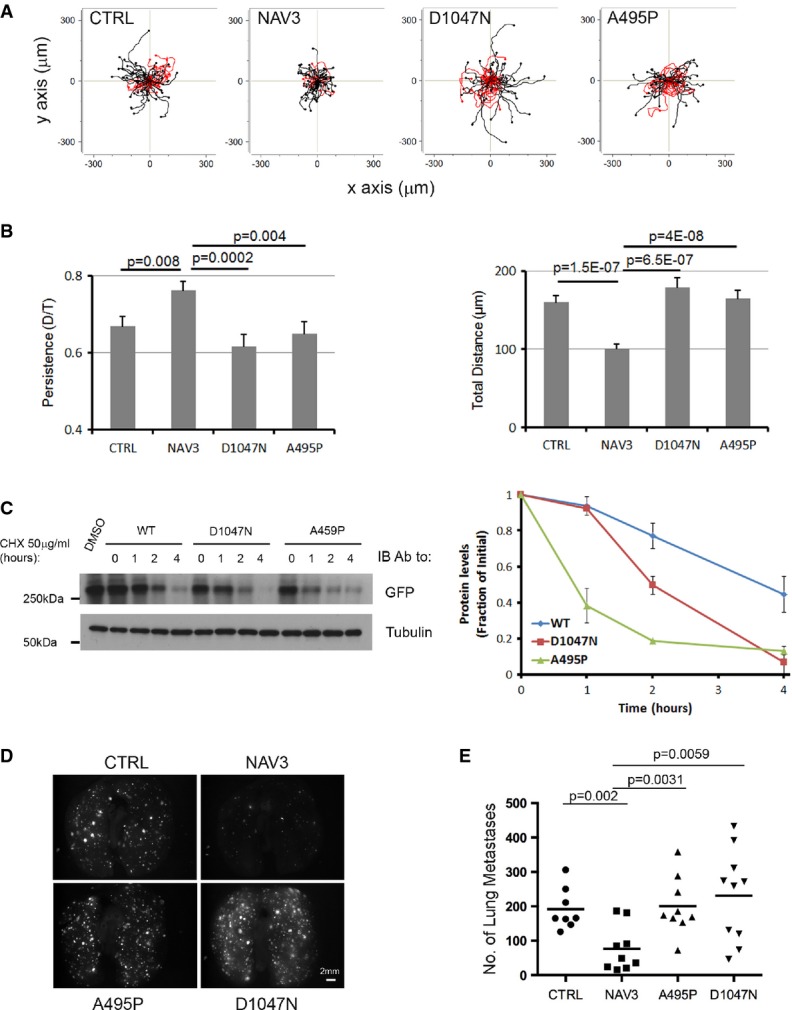
Unlike wild-type NAV3, mutant cancer alleles are devoid of persistency induction and metastasis suppression
A MCF10A cells were plated on collagen, and 24 h later, they were treated with EGF (10 ng/ml). Shown are trajectories of cells transiently expressing the indicated forms of NAV3. Red tracks indicate relatively low persistence (< 0.6).B Quantification of migration parameters (from A) is shown as mean ± SEM (60 cells and three experiments).C HEK293 cells previously transfected with EGFP-NAV3 (WT), EGFP-NAV3-D1047N or EGFP-NAV3-A459P were treated with cycloheximide (CHX; 50 μg/ml) or with the solvent, DMSO, for the indicated time intervals, followed by cell lysis and immunoblotting using anti-EGFP and anti-α-tubulin antibodies. The signals obtained were quantified and normalized to time zero (untreated cells; right panel).D, E The indicated mCherry-expressing MDA-MB-231 derivatives were injected intravenously (1.5 × 105 per mouse) using 5-week-old female SCID mice. Four weeks later, lungs were photographed and the numbers of lung metastases were determined.
Source data are available online for this figure.